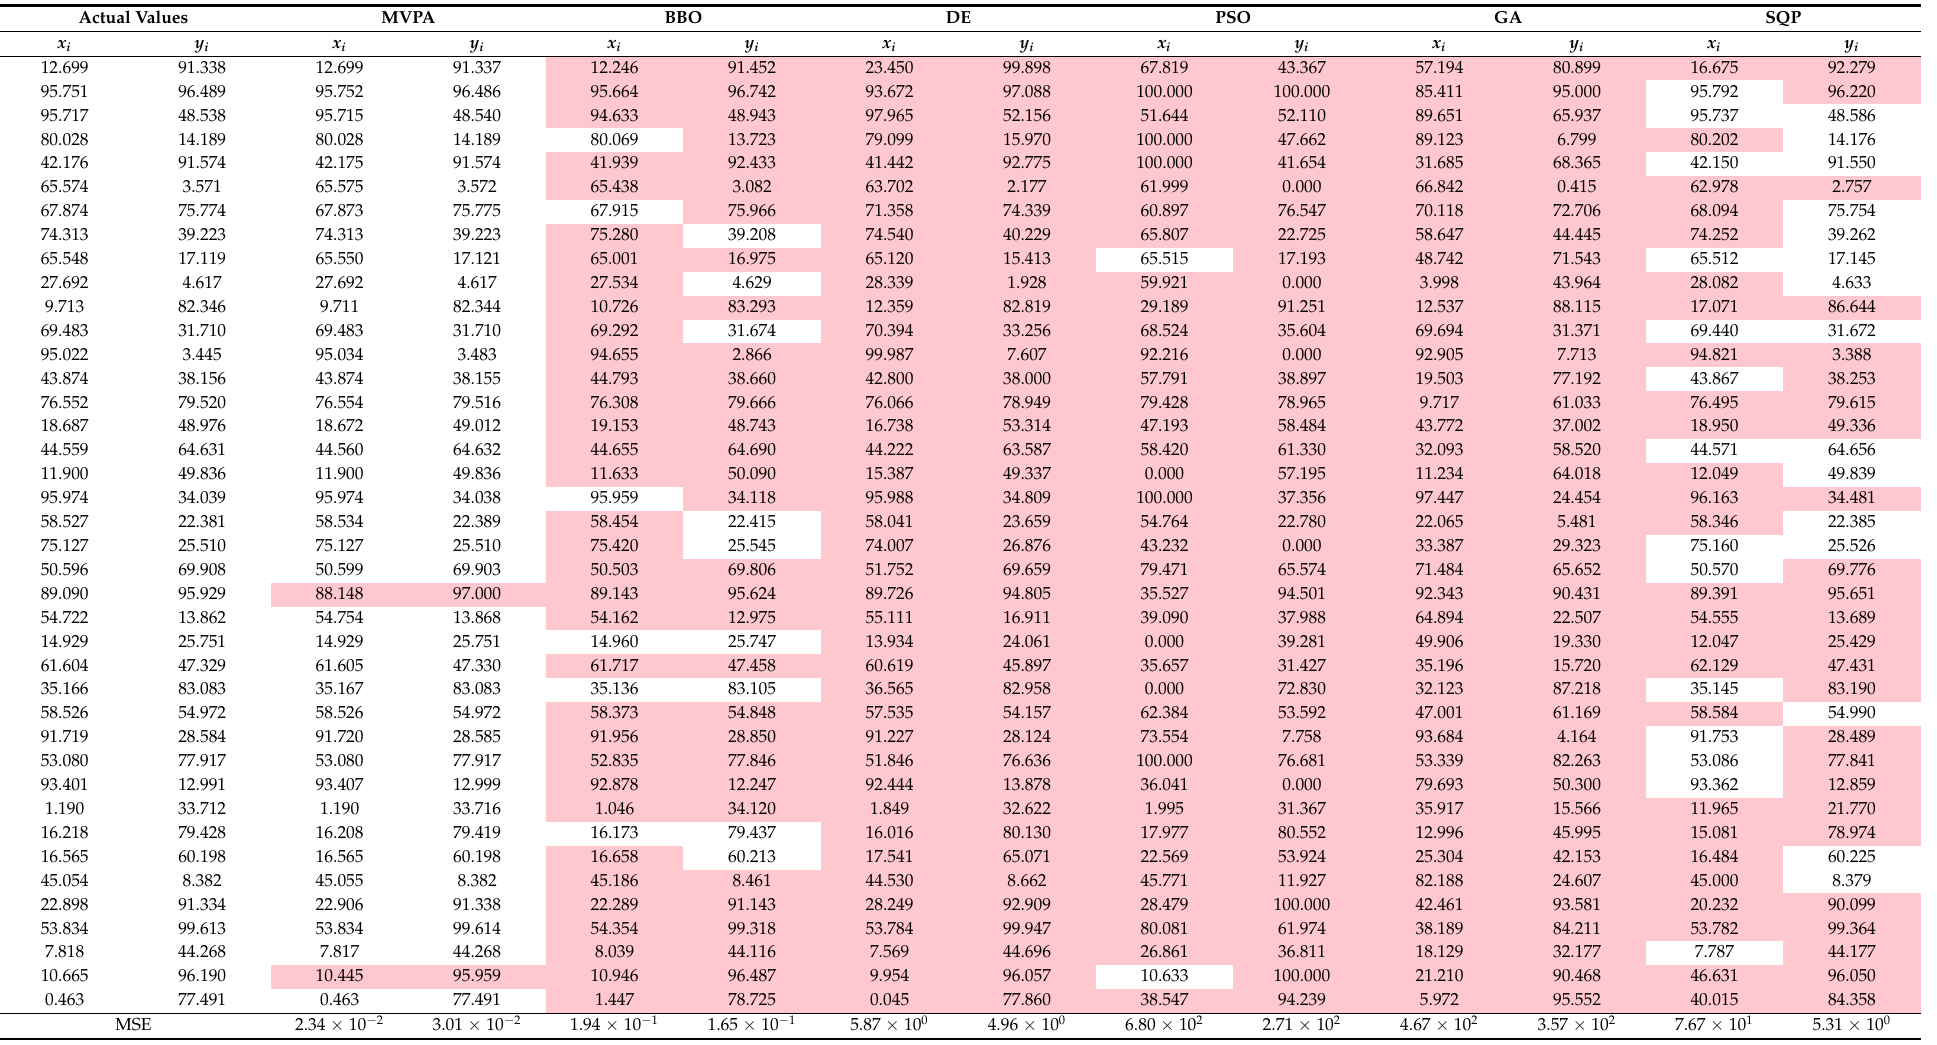
Table 3. Comparison of actual locations with those obtained using different algorithms for case